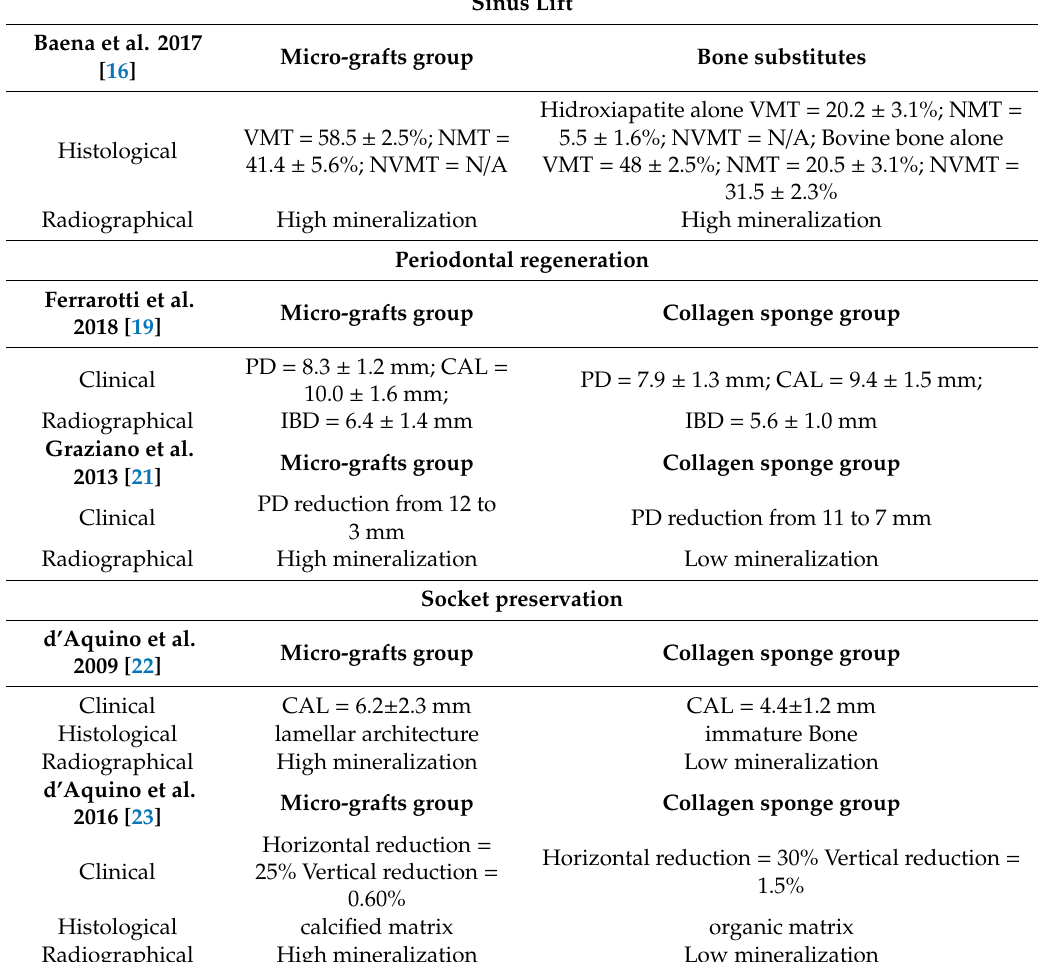
Table 3. Results extracted from test and control sites with follow-up periods of 4 months for sinus lift procedures, 6 and 12 months for periodontal regeneration, and 3 and 4 months for socket